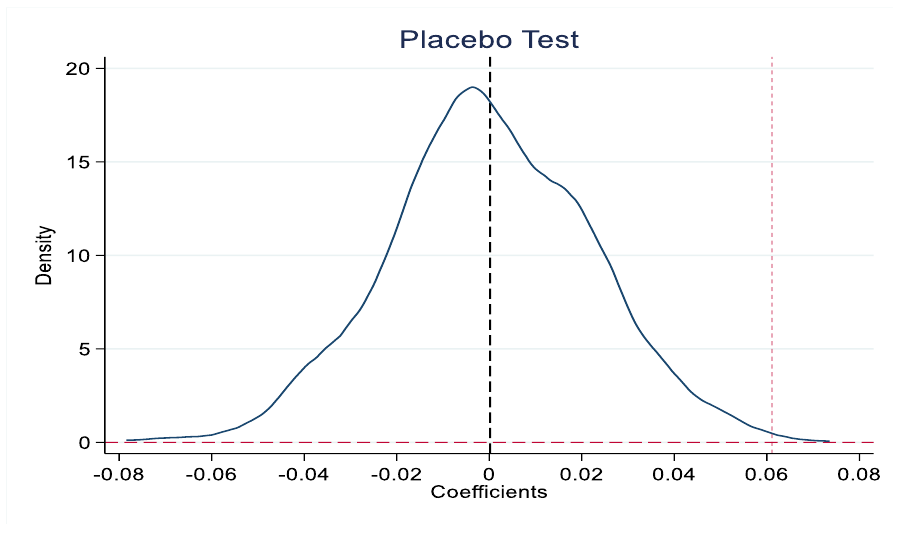
Figure 2. Placebo test. Table 4. Other robustness